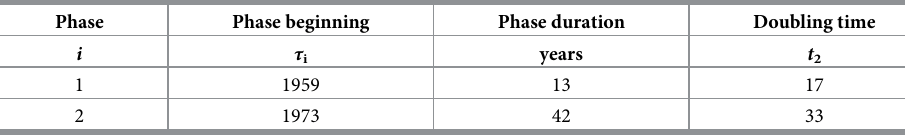
Table 1. Stepwise exponential model parameter